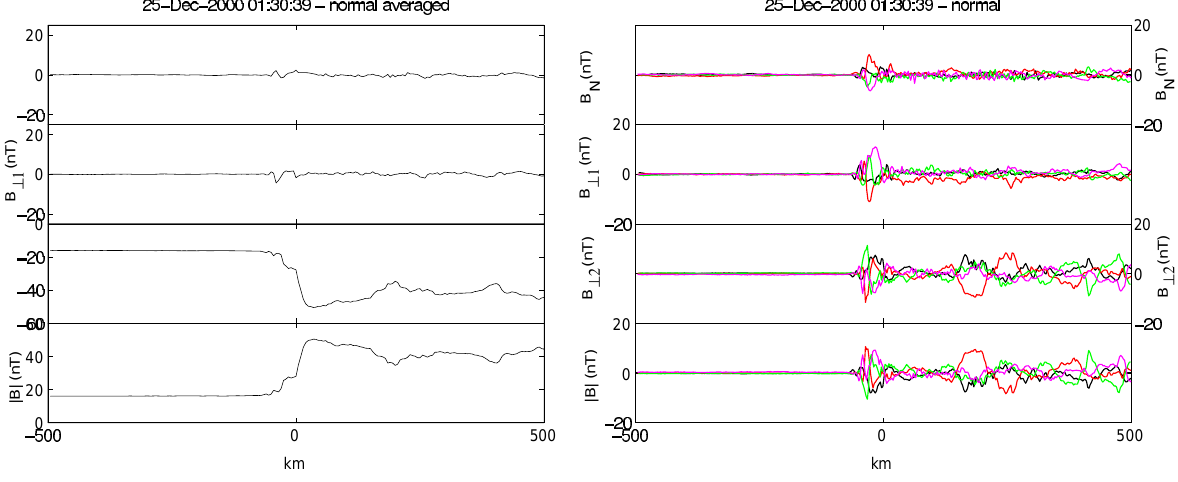
Fig. 7. (left) Magnetic field profile through the shock shown in Fig. 6, averaged over the four Cluster spacecraft. (right) Magnetic field variations, in a normal-aligned coordinate system, after the averaged field profile has been removed. Large waves are visible in the foot and beginning of the